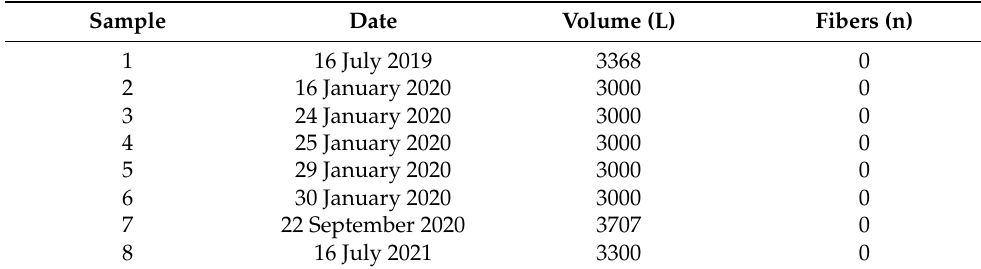
Table 1. Evaluation of environmental ambient air asbestos